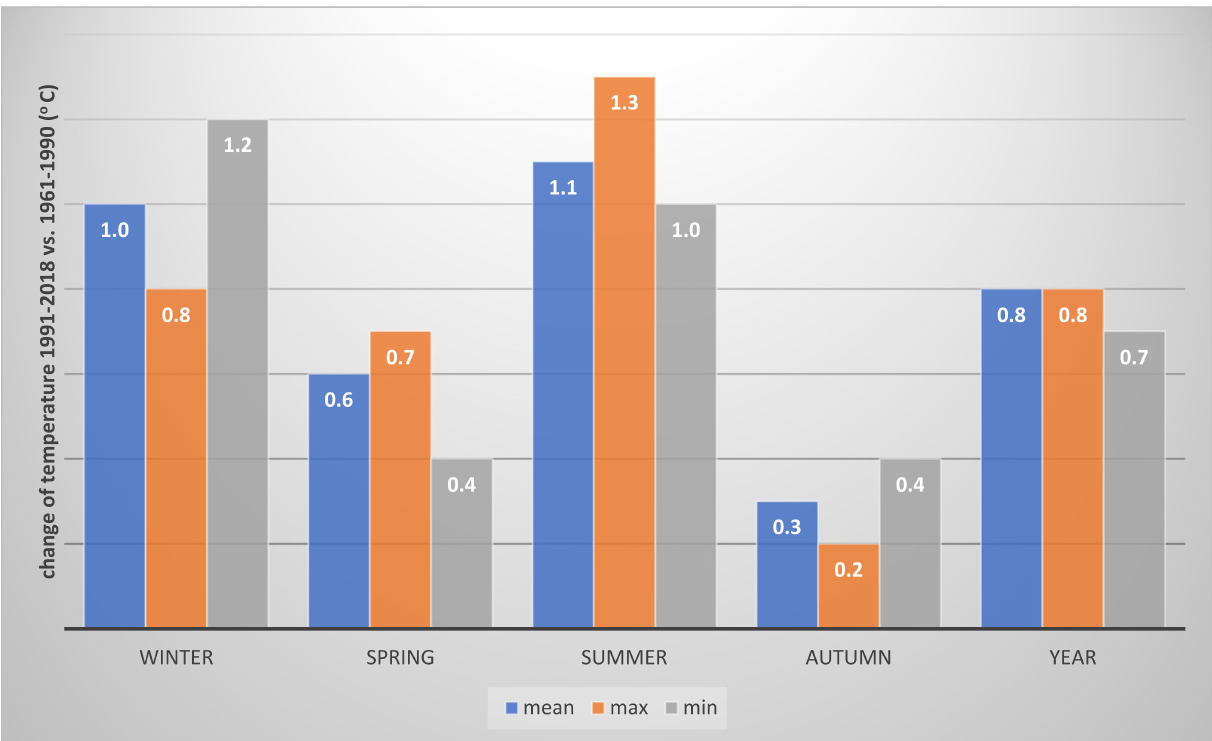
Figure 1. The changes of temperatures ( ◦ C) in 1991–2018 years compared to the 1961–1990 (prepared using Balabuh data